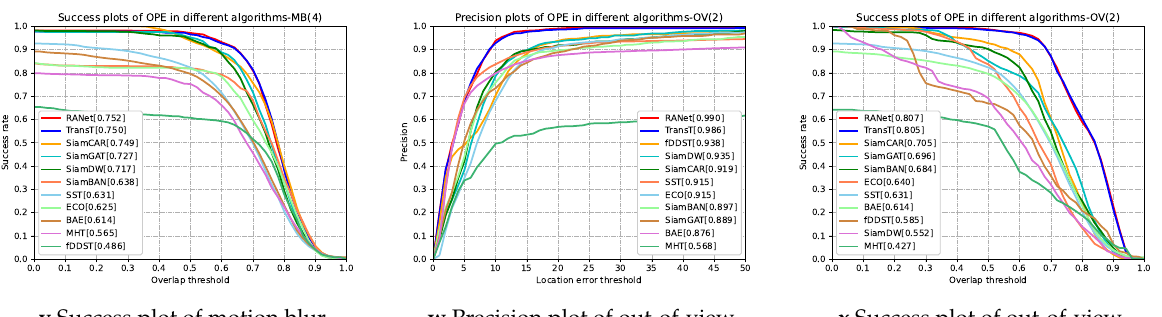
Figure 9. Success plots and precision plots of 11 trackers under overall attributes and different challenge